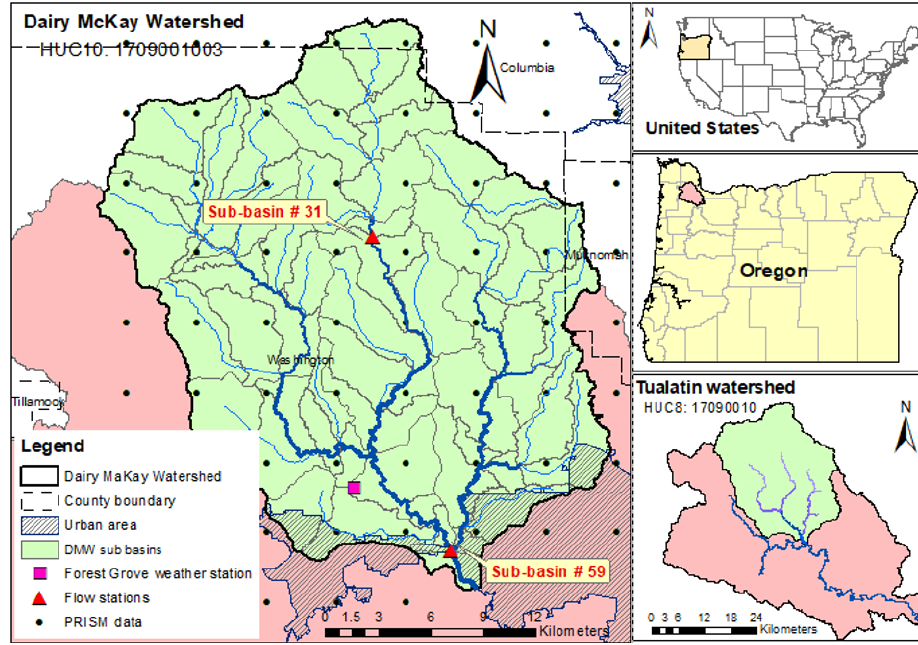
Figure 1. Left: streams, sub-watersheds, and political boundaries of the Dairy McKay Watershed (DMW) (HUC10-1709001003). Top right: location of DMW in the Tualatin River basin; bottom right: location of the Tualatin River basin in northwestern Oregon, USA.